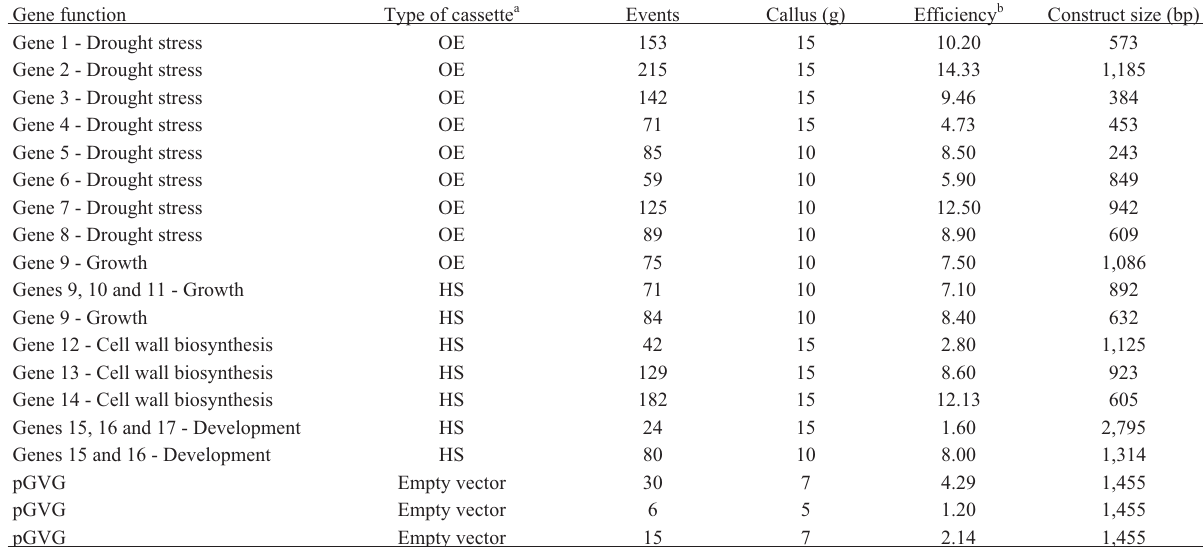
Table 1 - Transformation efficiency in sugarcane using